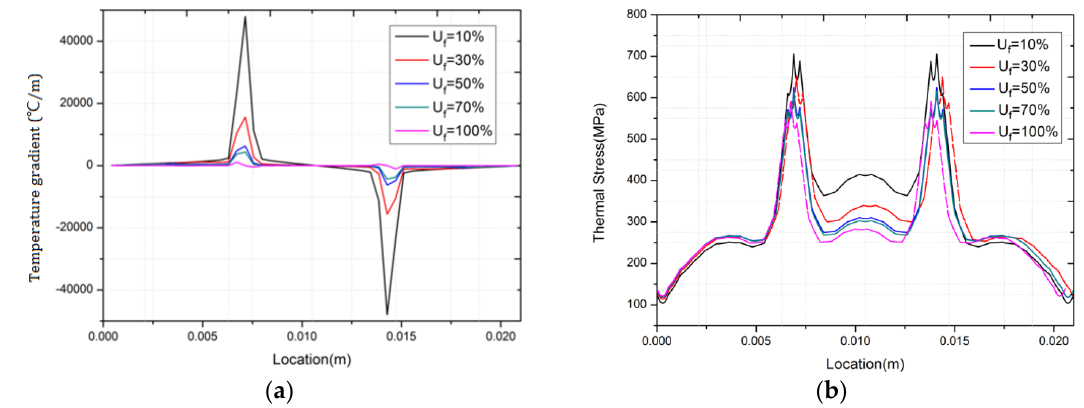
Figure 15. Temperature gradient and thermal stress distributions along Line 1 (P = 13.23 W): ( a ) temperature gradient distribution; ( b ) thermal stress distribution.